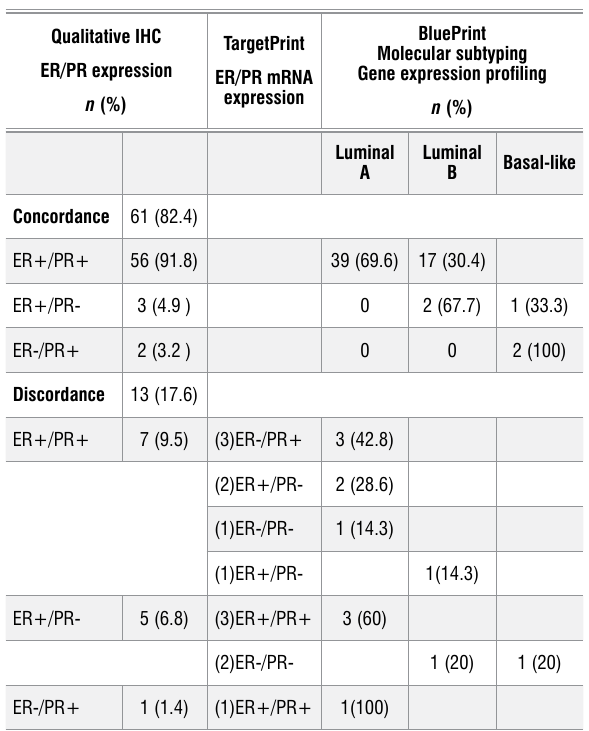
Tumour classification according to molecular subtyping (BluePrint) assessed in relation to ER/PR status in IHC/TargetPrint concordant ( n =61) as well as discordant ( n =13) cases